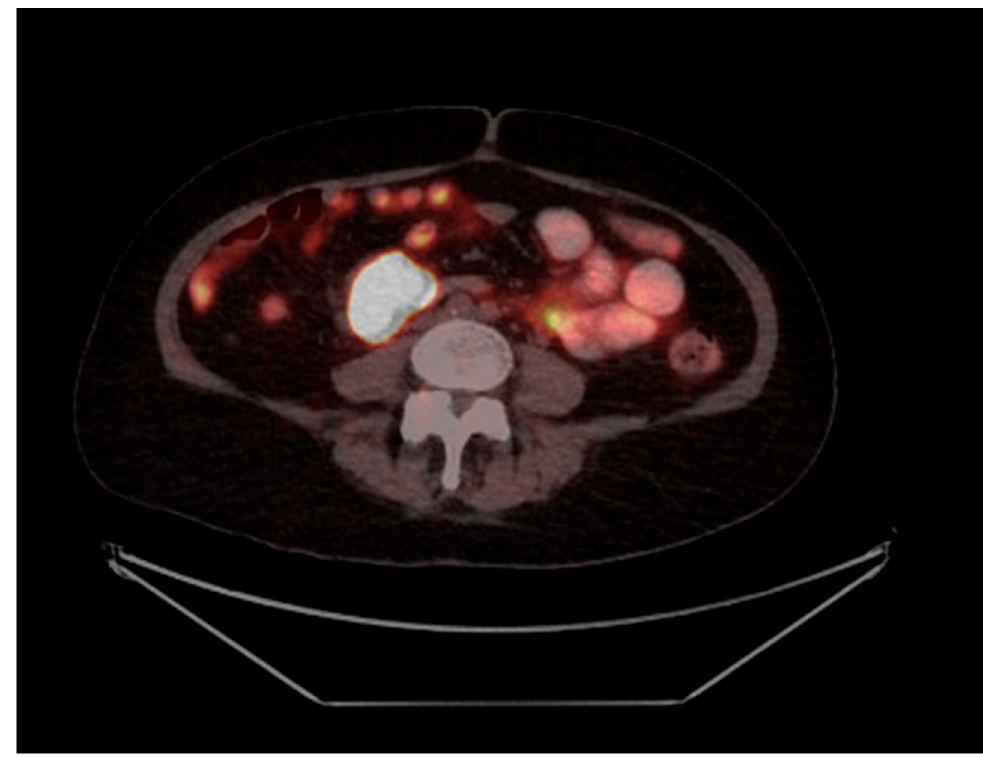
Figure 1. CT axial slice of the abdomen as part of the PET Gallium DOTATATE scan showing DOTATATE uptake of the mesenteric mass 47 × 28 mm.